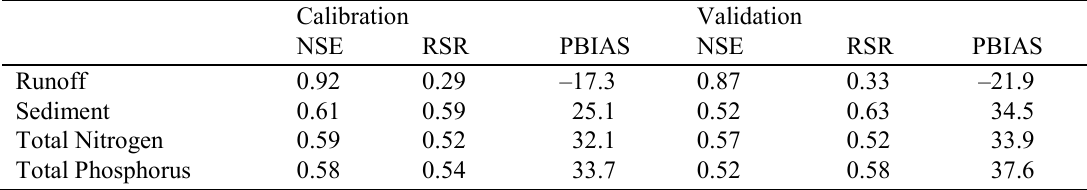
Table 1 Reproducibility of estimation by SWAT model Calibration